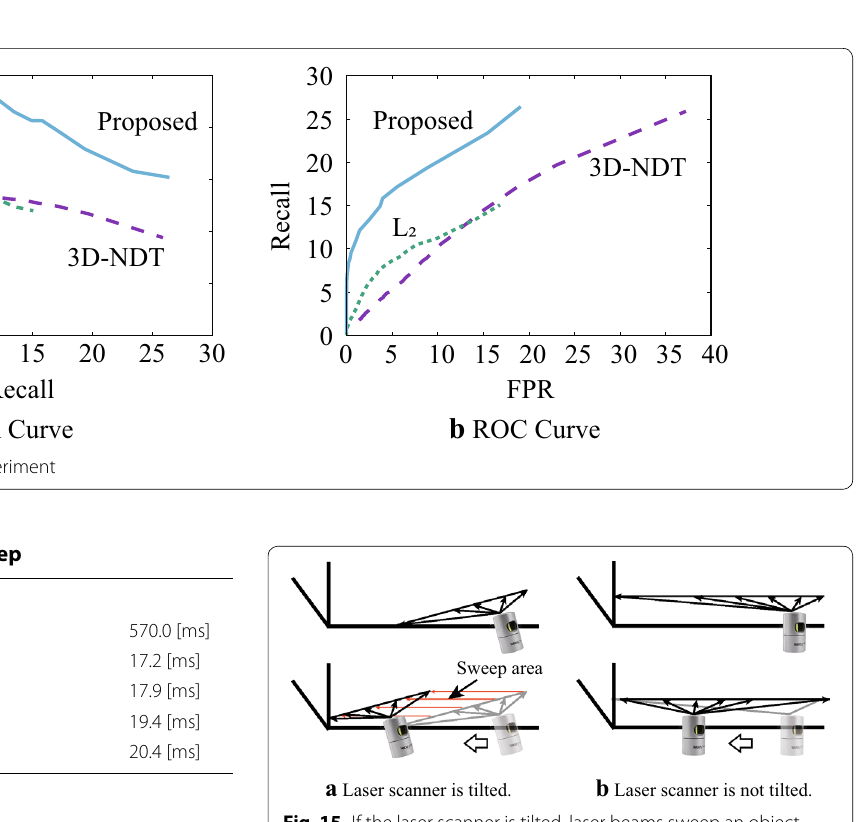
Fig. 15 If the laser scanner is tilted, laser beams sweep an object such as a wall along the moving direction densely